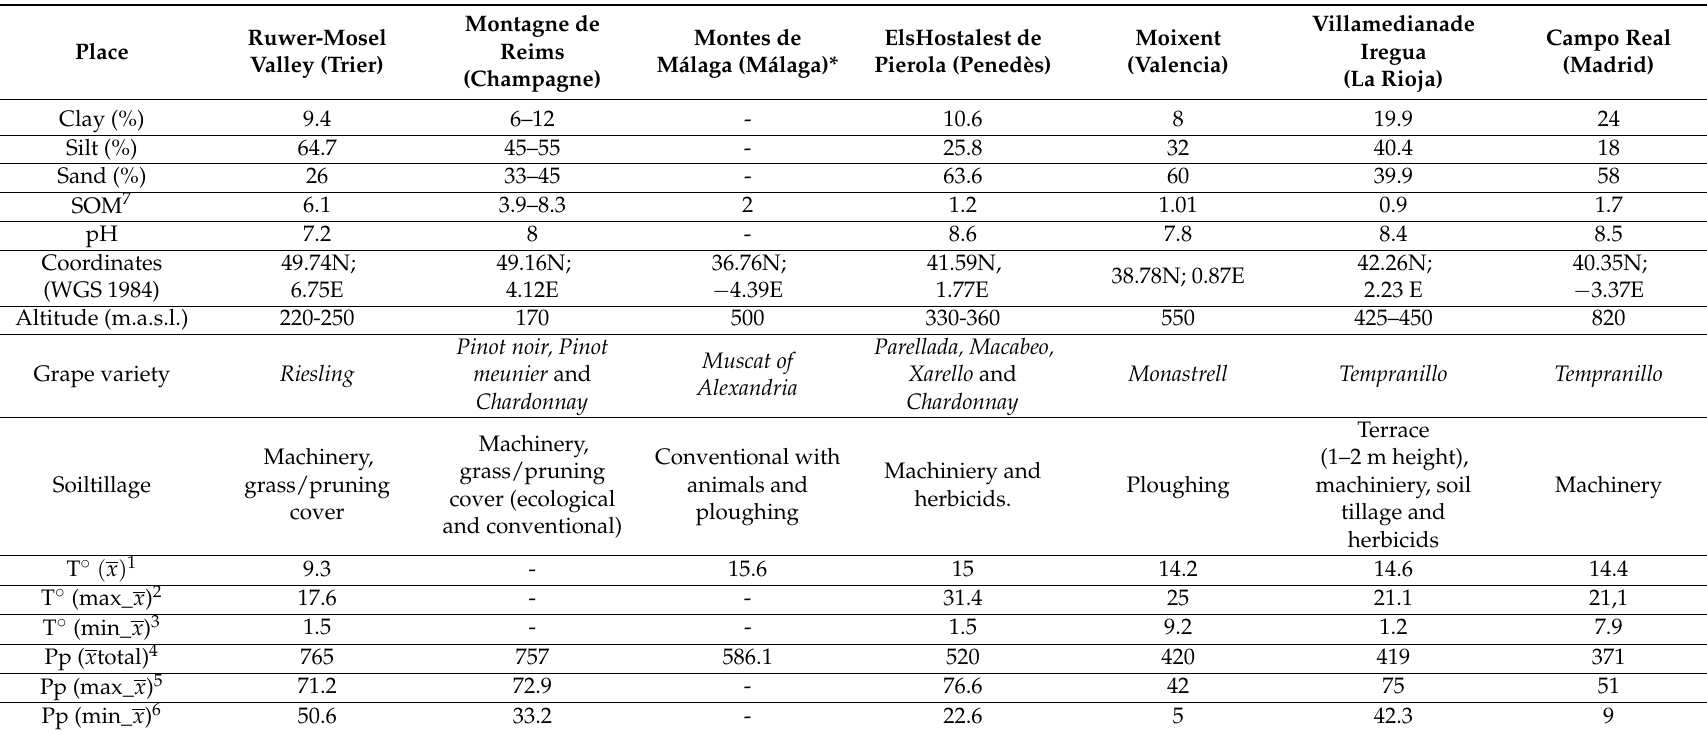
Table 1. Study areas with their